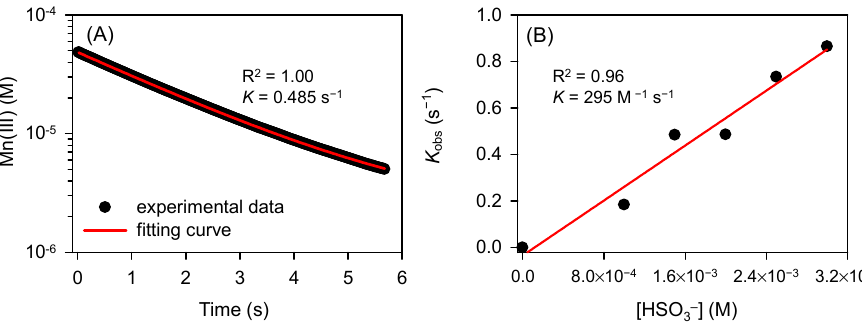
Figure 2. ( A ) Time course of Mn(III) (50 µM) reduction by HSO 3 − (2000 µM); ( B ) linear relationship between measured pseudo-first-order rate constants ( k obs , s − 1 ) and HSO 3 − concentrations. Conditions: [PP] 0 = 2.5 mM, pH = 7.0.